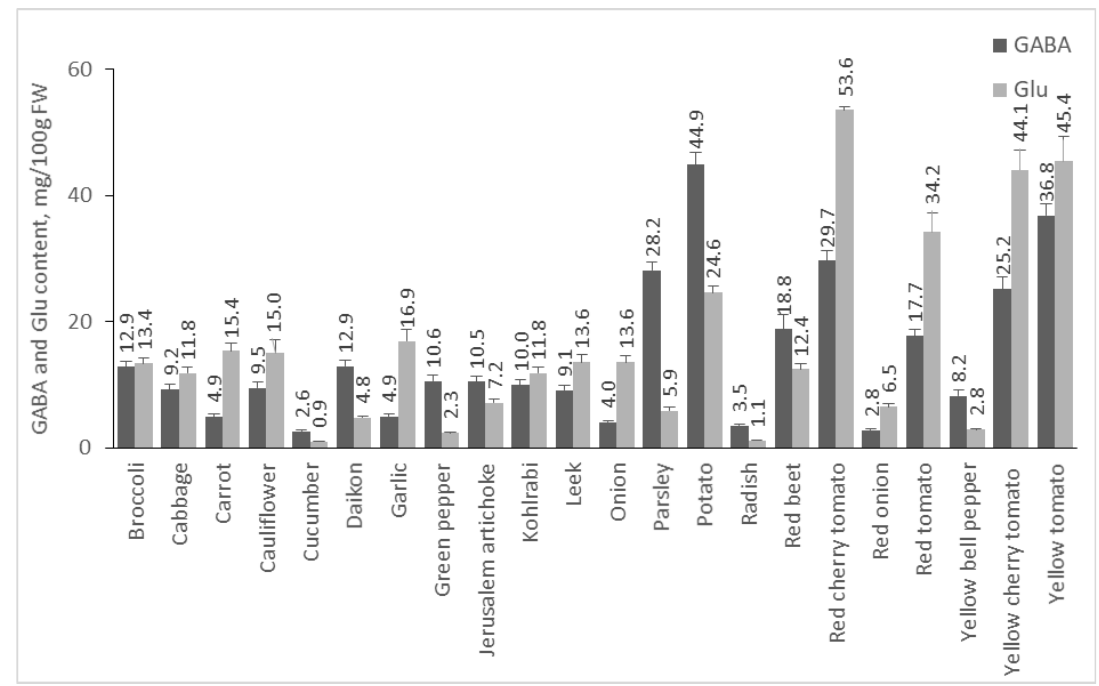
Figure 2. GABA and Glu content of vegetables. Results are presented as mean values ± standard deviation (SD).